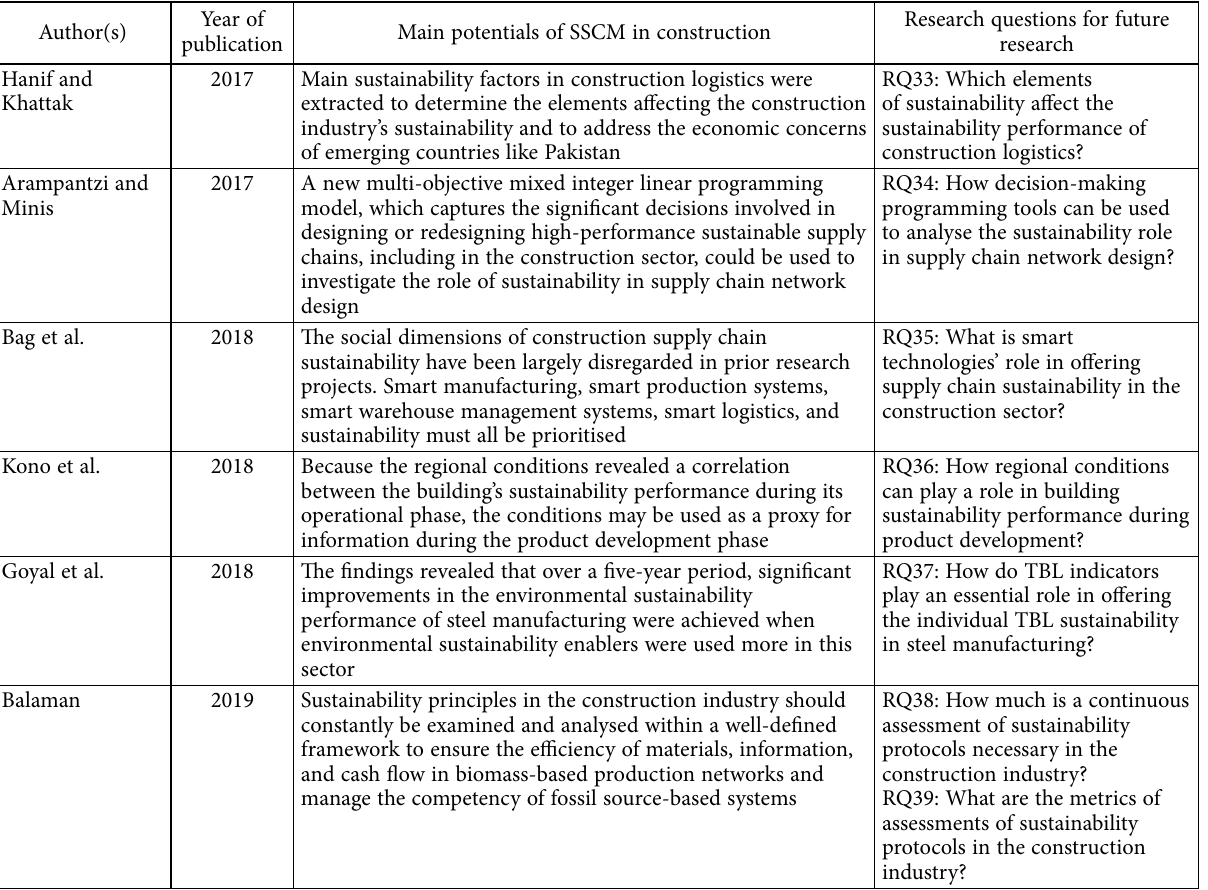
Table 3. Future research questions emerge from the potentials of SSCM in